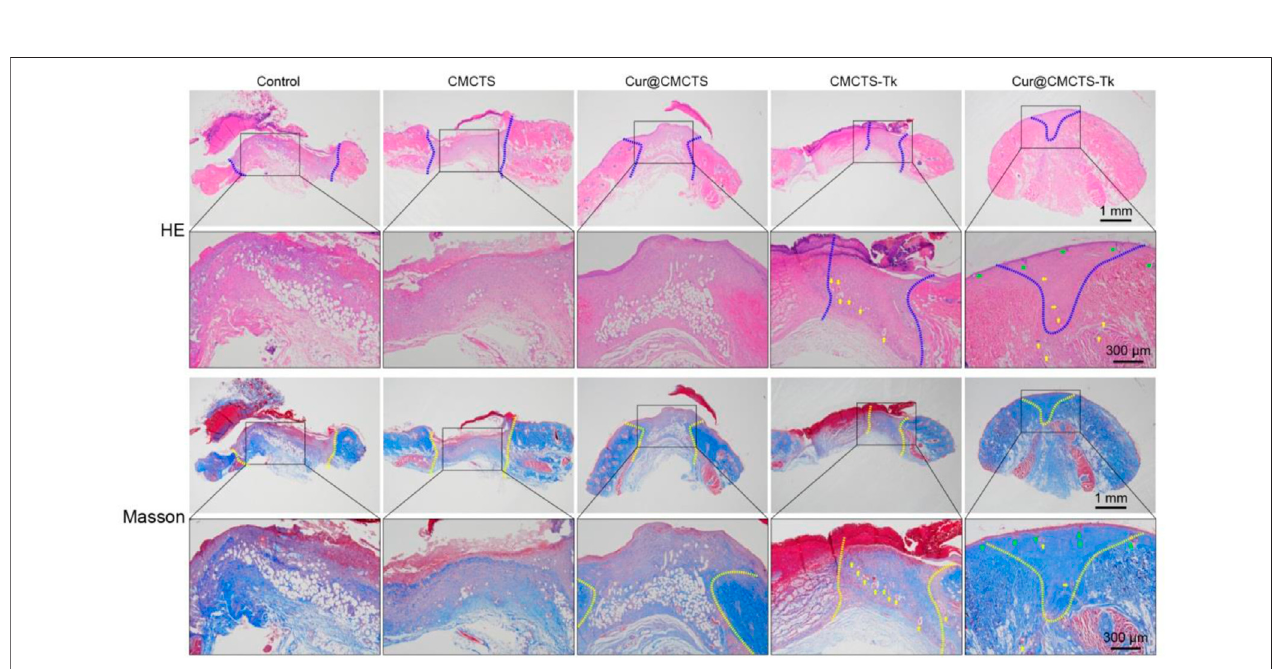
FIGURE 8 | In vivo wound healing effect of Cur@CMCTS-Tk hydrogels. Representative images of sections stained with H&E (top) and Masson ’ s trichrome (bottom) from normal skin and wounded skin treated with/without hydrogels at day 21 post-wounding (the area within the blue or yellow dashed line is not healed and the yellow arrows represent micrangium). Diminished image scale bars are 1 mm, enlarged image scale bars are 300 µm.